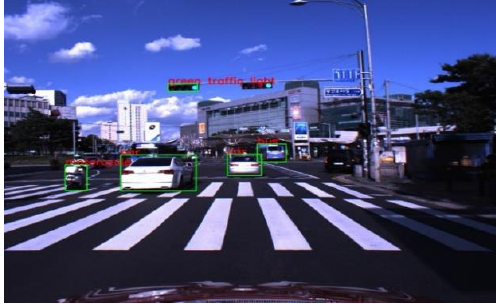
Figure 4. Results of traffic light detection and colour classification